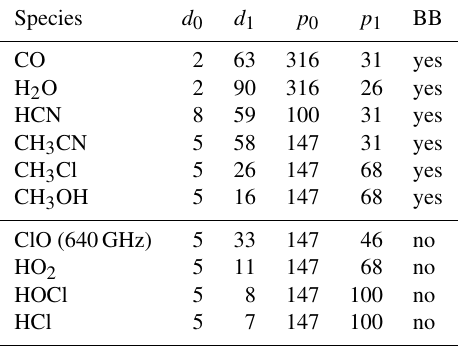
Table 2. Summary of species observed by MLS to have clearly en- hanced mixing ratios in the polluted air mass. The first and last days after 12 August 2017 are listed as d 0 and d 1 ; the highest and low- est pressures at which unusual values are observed are listed as p 0 and p 1 . The “BB” column indicates whether or not the species is a genuine biomass burning product. For some species the enhanced values are thought to be caused by a measurement problem (see main text). Species observed by the instrument but with no unusual values detected in the polluted air mass are O 3 , SO 2 , BrO, HNO 3 and N 2 O. Species d 0